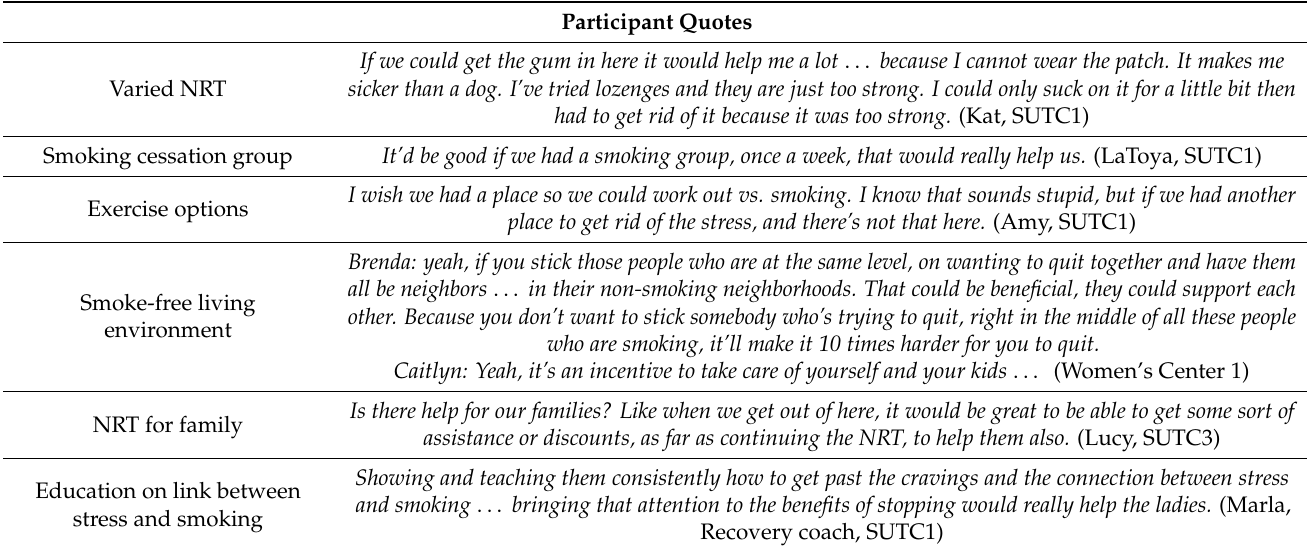
Table 3. Specific program recommendations from clients and